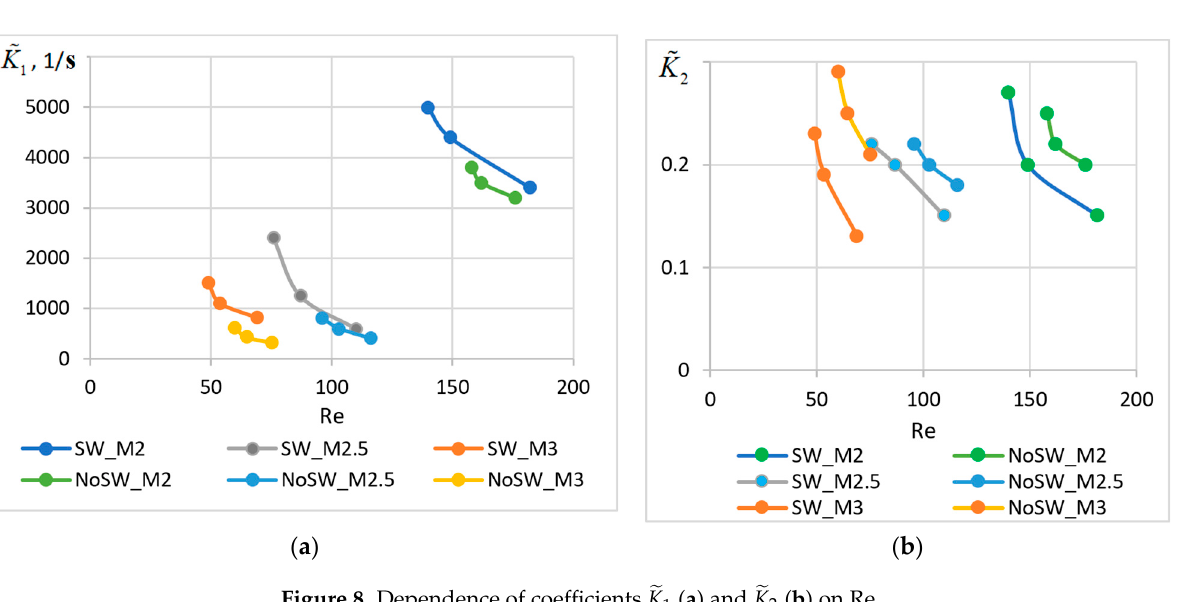
Figure 8. Dependence of coefficients